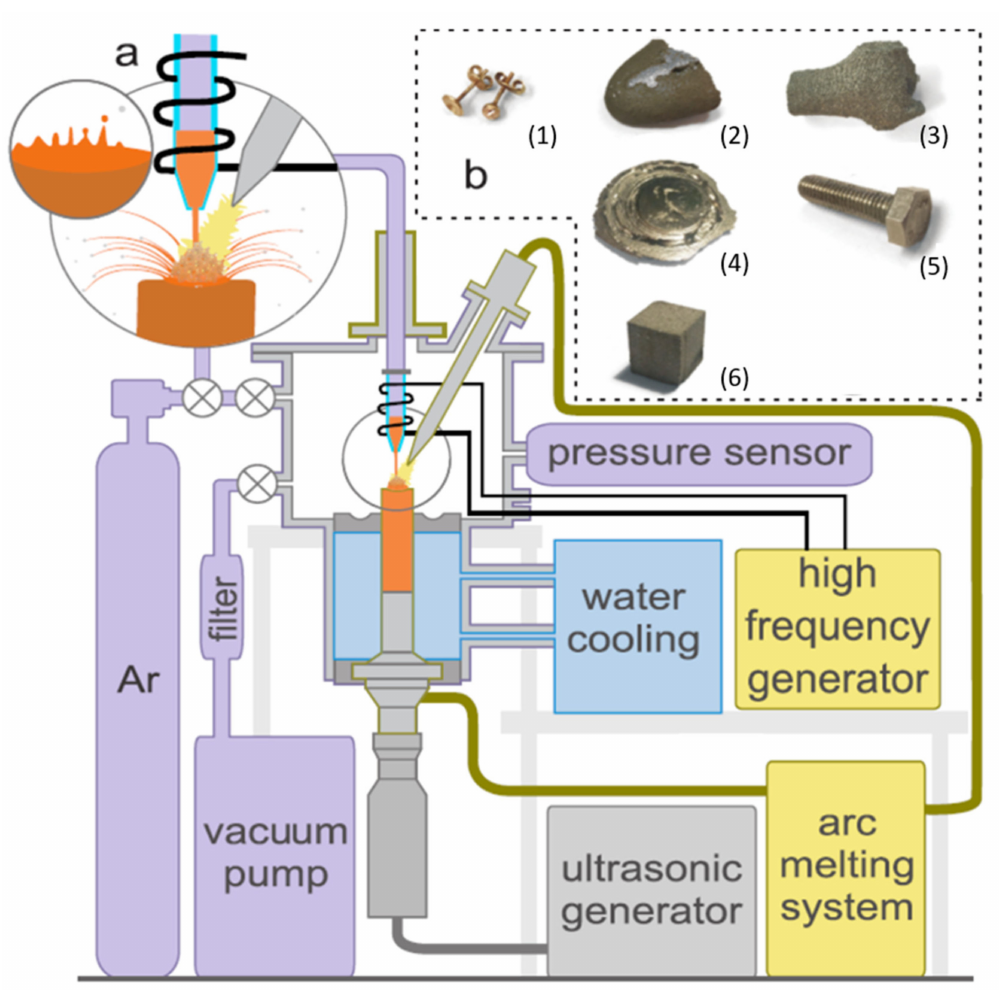
Figure 1. Process diagram and experimental setup ( a ), material feedstock ( b ): (1) Au-based alloy earrings, (2) AMZ4 (Heraeus GmbH) Zr-based metallic glass, (3) slabs of Ni–Mn–Ga magnetocaloric alloy, (4) forged equiatomic Fe–Cr–Mn–Ni high entropy alloy, (5) AISI 304 steel as a M10 bolt, (6) Grade 2 titanium porous